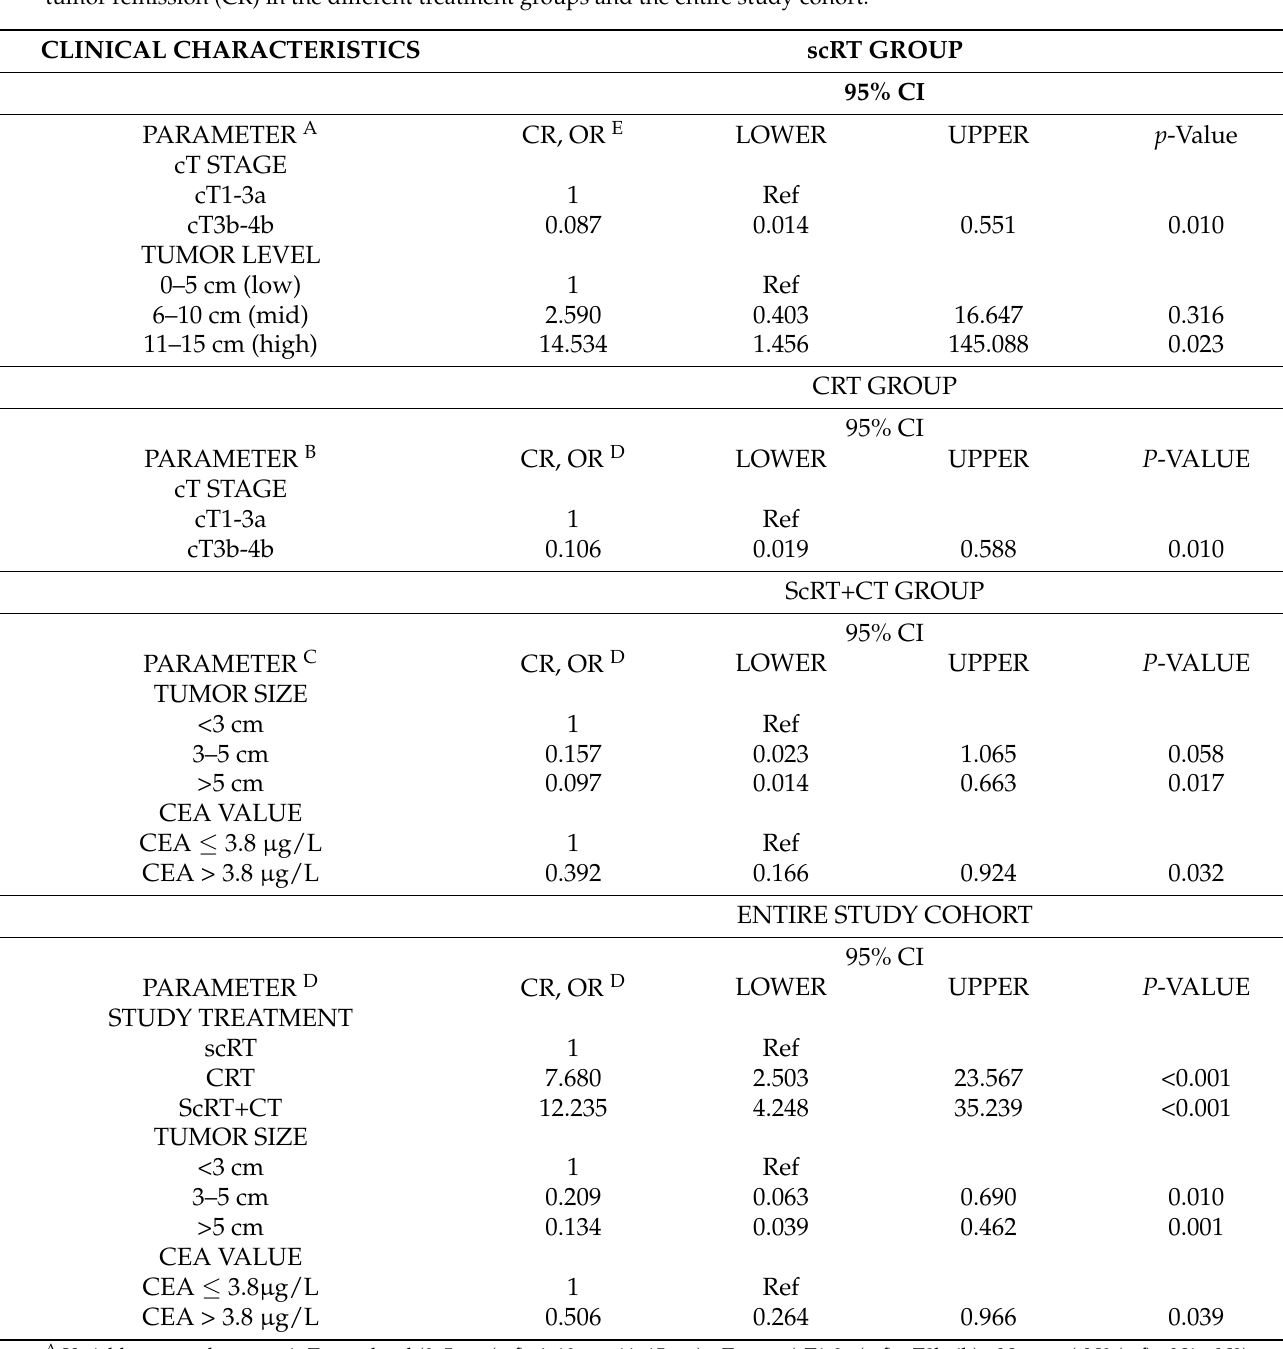
Table 4. Stepwise logistic regression with backward elimination model for identification of factors associated with complete tumor remission (CR) in the different treatment groups and the entire study